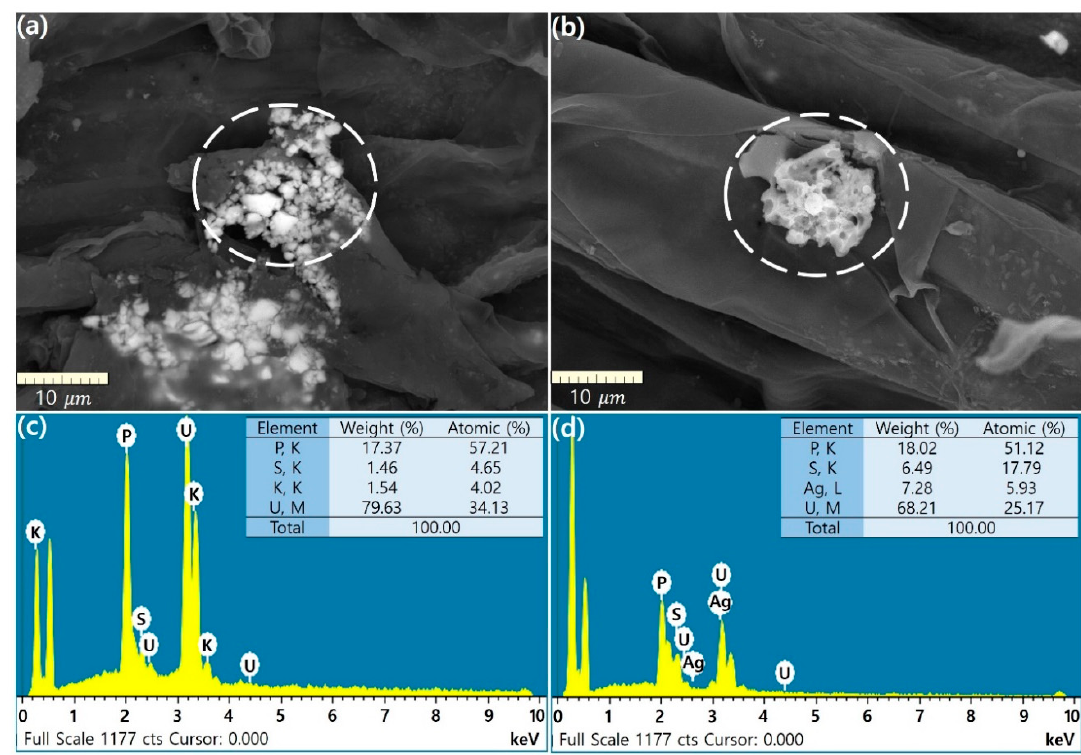
Figure 5. SEM micrographs of Raphanus sativus L. roots after rhizofiltration and EDS spectra for a cluster of white crystalline particles ( a , c ) and a big white crystal particle ( b , d ) in the dashed white circle.